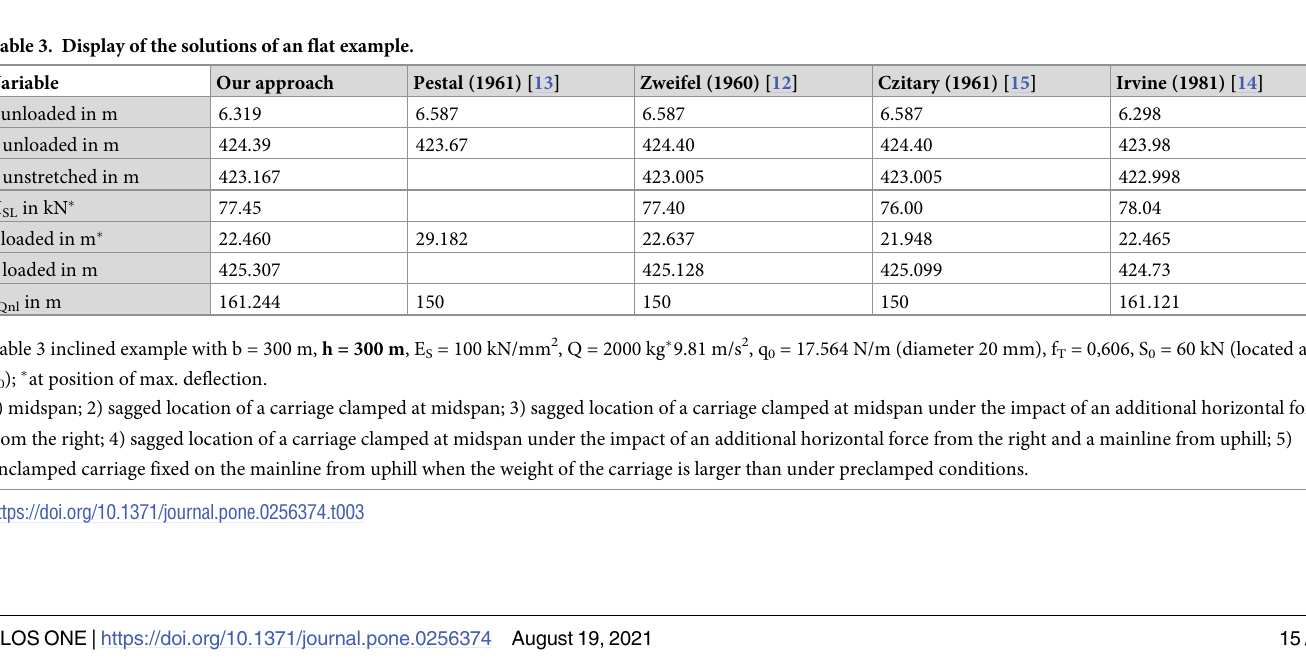
Table 3. Display of the solutions of an flat example.